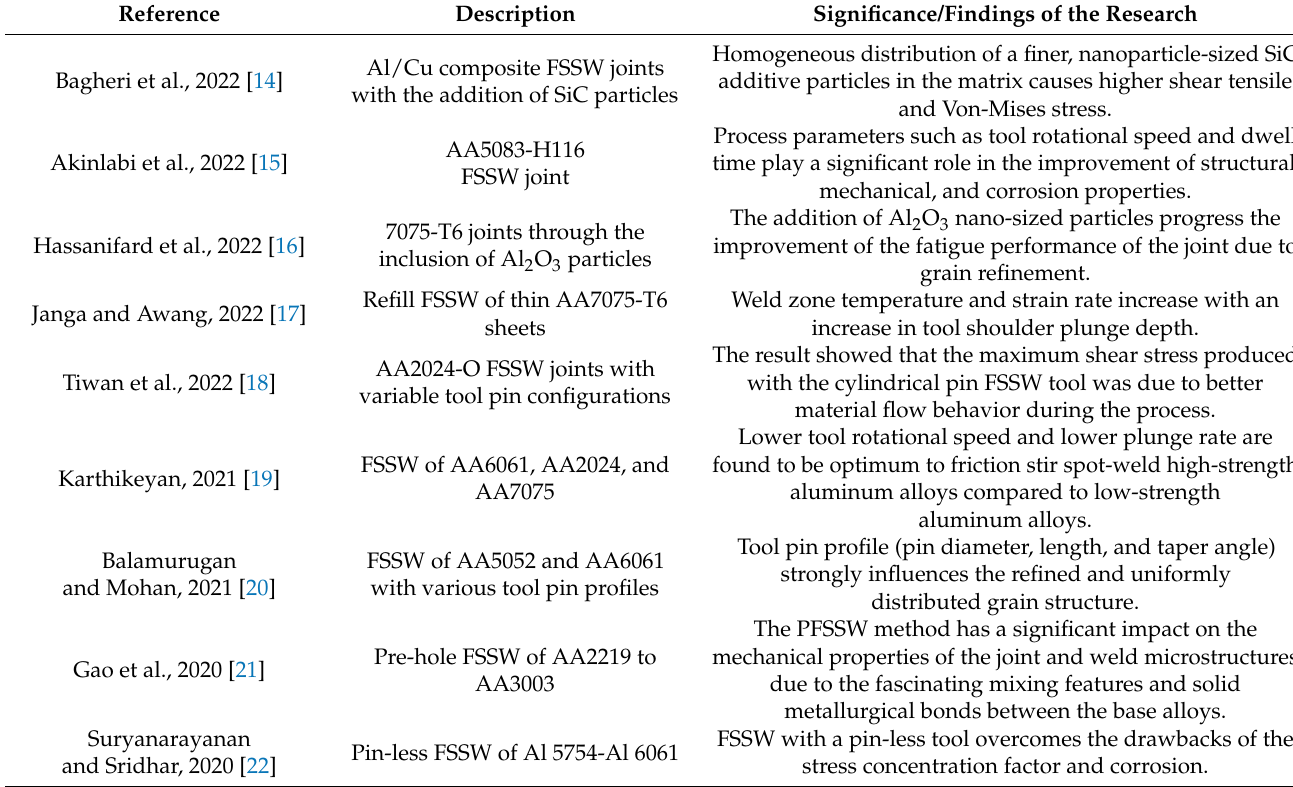
Table 1. Recently published literature on the FSSW of aluminum